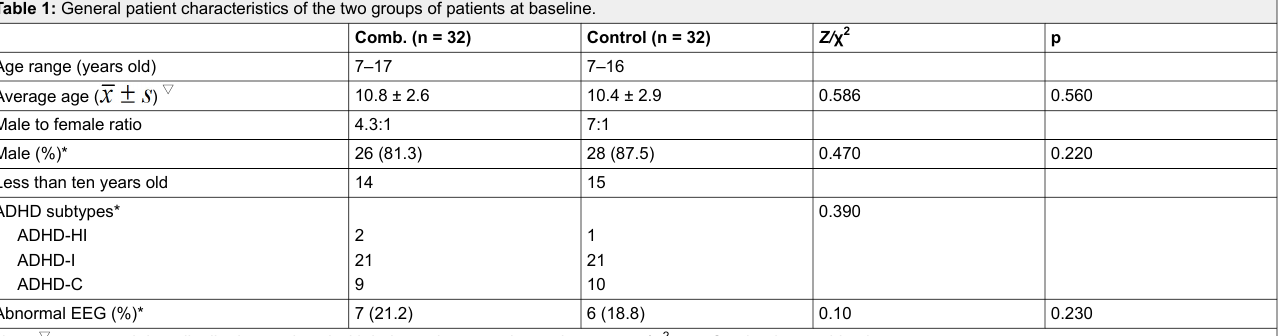
Table 1: General patient characteristics of the two groups of patients at baseline.